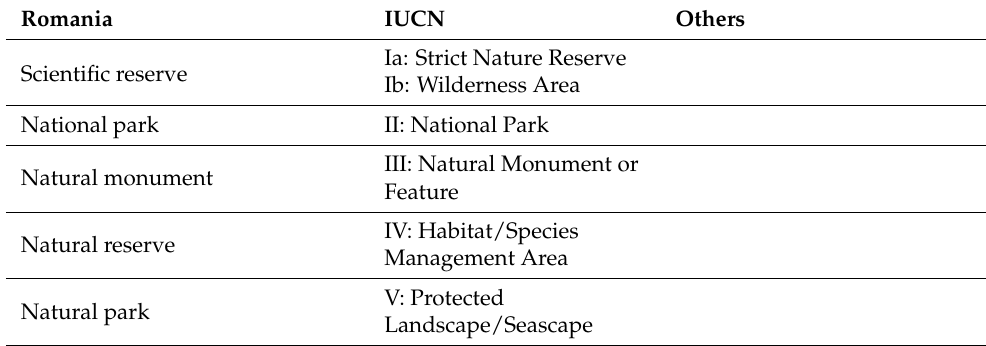
Table 1. Romania’s system of natural protected areas in the context of IUCN and other international